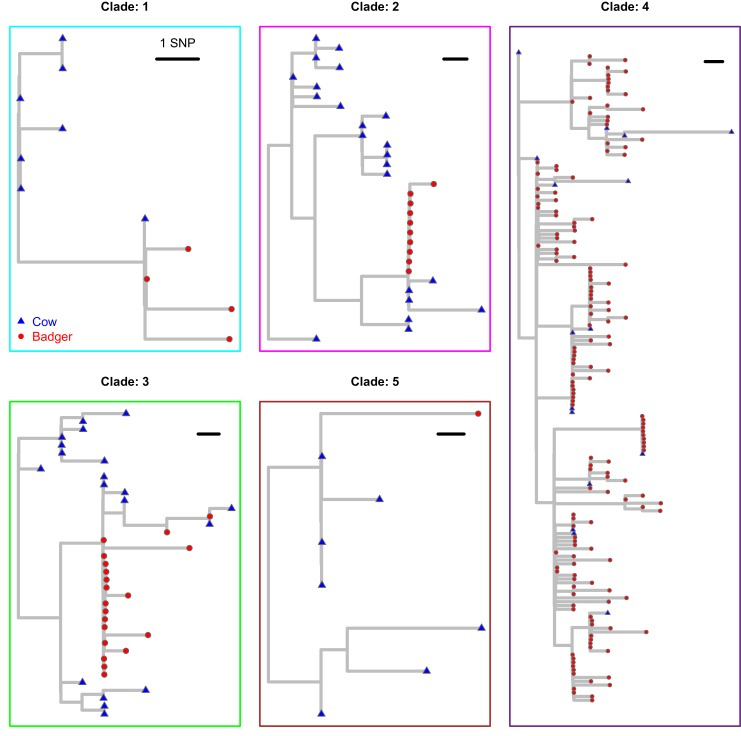
Each of the clades from Figure 1 in the main manuscript are plotted separately.These clades were extracted from the Maximum Likelihood phylogenetic tree constructed using RAxML (v8.2.11; Stamatakis, 2014) and rooted against the M. bovis reference sequence, AF2122/97 (Malone et al., 2017). Badger and cattle isolates are represented at the tips of the phylogeny by red circles and blue triangles, respectively.